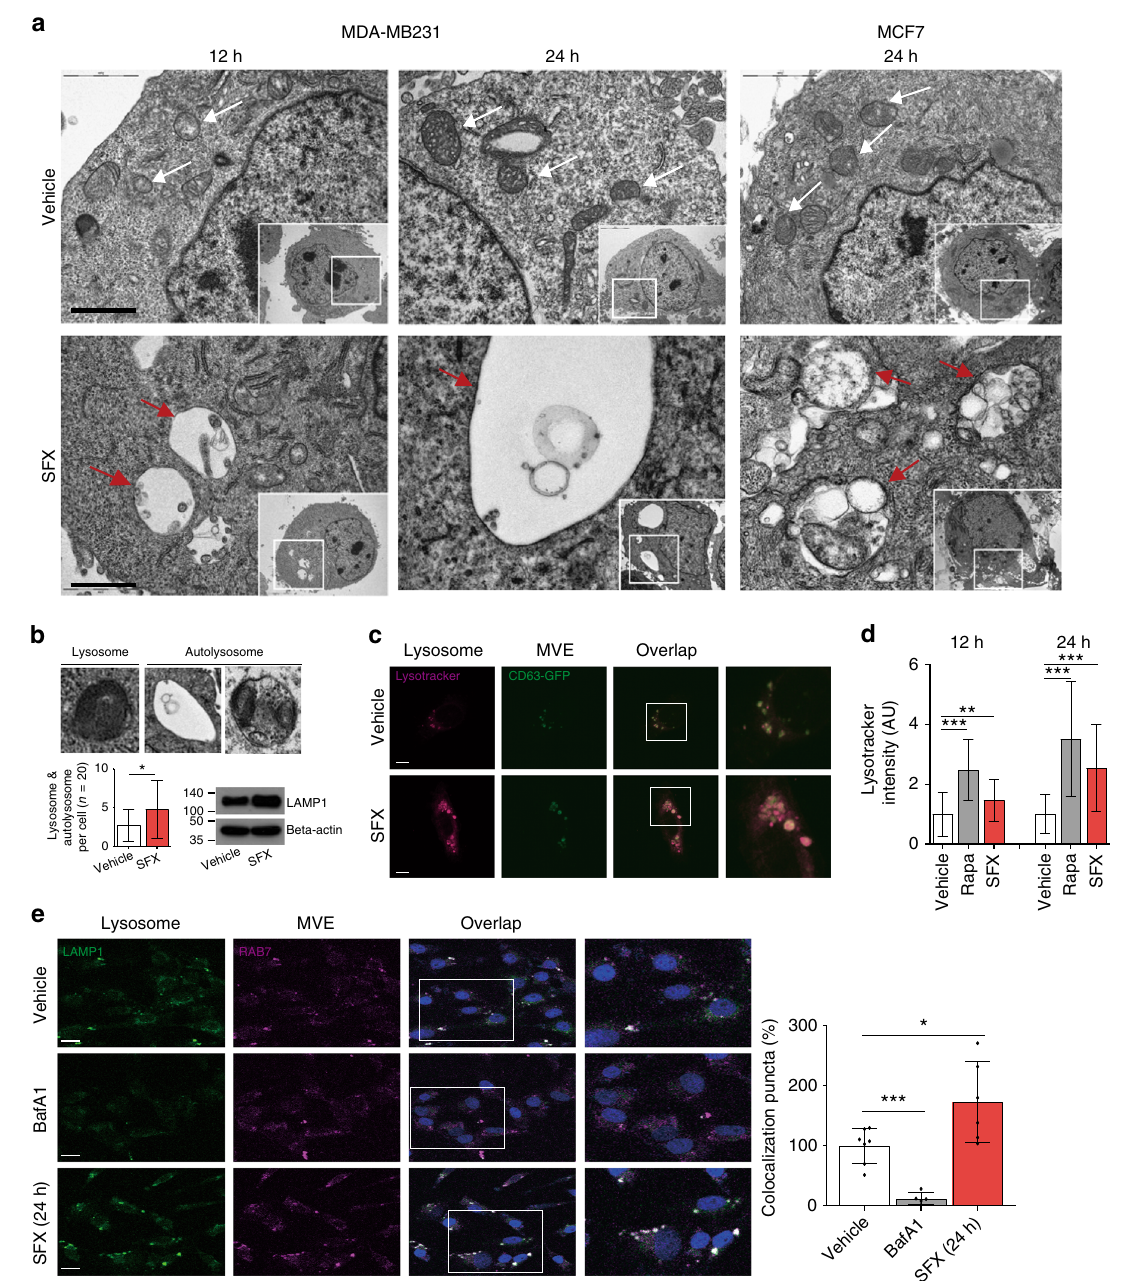
Fig. 6 SFX induces fusion of MVE with lysosomes in breast cancer cells. a TEM analysis of SFX-treated MDA-MB231 cells. Red arrows indicated unusual structures in SFX-treated MDA-MB231 and MCF7, and white arrows indicated MVEs in control cells. Scale bar, 5 μ m. b Top, Images of lysosome and autolysosome structures observed in SFX-treated MDA-MB231 cells. Bottom left, the numbers of distributed lysosome and autolysosome structures were counted. n = 20. Bottom right, LAMP-1 protein expression was upregulated in SFX-treated MDA-MB231 cells. n = 3. c Confocal image of CD63-GFP ( + )-MDA-MB231 in the presence or absence of SFX. Red, lysotracker. Green, CD63-GFP. Scale bar, 2 μ m. d Measurement of Lysotracker (red) intensity in rapamycin-treated (positive control) or SFX-treated MDA-MB231 cells. Lysotracker intensity measurement >170 cells per group. e Left, Image of MDA- MB231 treated by 100 μ M SFX. Green, CellLight-Lysosome-GFP (GFP-LAMP1). Red, CellLight-late endosome/MVE-RFP (RFP-RAB7). Scale bar, 2 μ m. Right, Quantitative colocalization rates of lysosomes and MVE in SFX-treated MDA-MB231. Colocalization puncta count >60 cells per group using ImageJ program. Ba fi lomycin A1 (BafA1) was used as a negative control. Experiments were performed with 95% con fl uent cells. Signi fi cance was determined using an unpaired two-tailed Student ’ s t -test. *** p < 0.001, ** p < 0.005 and * p < 0.05. Error bar, SD. Source data ( b , d, e ) are provided as a Source Data fi